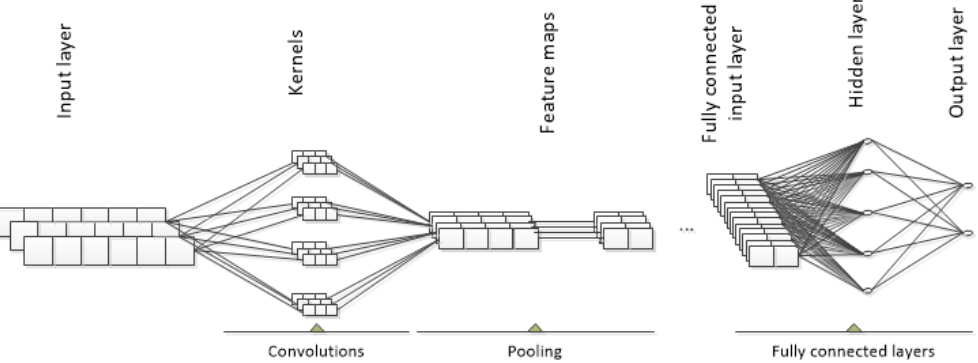
Figure 1. Generic structure of multi-channels 1D Convolutional Neural Network